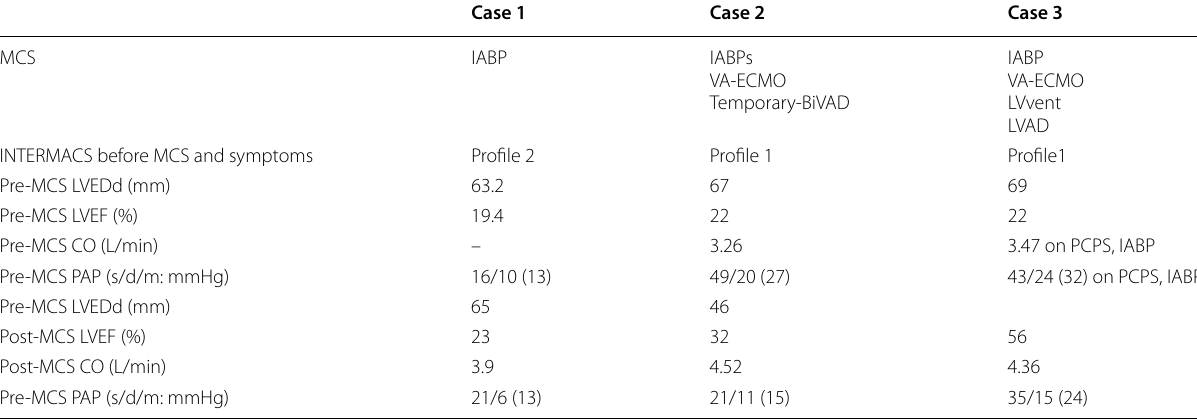
LVEF left ventricular ejection fraction, LVEDd left ventricular end-diastolic diameter, CO cardiac output, PAP pulmonary atrial pressure, MCS mechanical circulatory support, PCPS percutaneous cardiopulmonary support, IABP intra-aortic balloon pump, VA-ECMO veno-arterial extracorporeal membrane oxygenation, BiVAD biventricular assist device, LVAD left ventricular assist